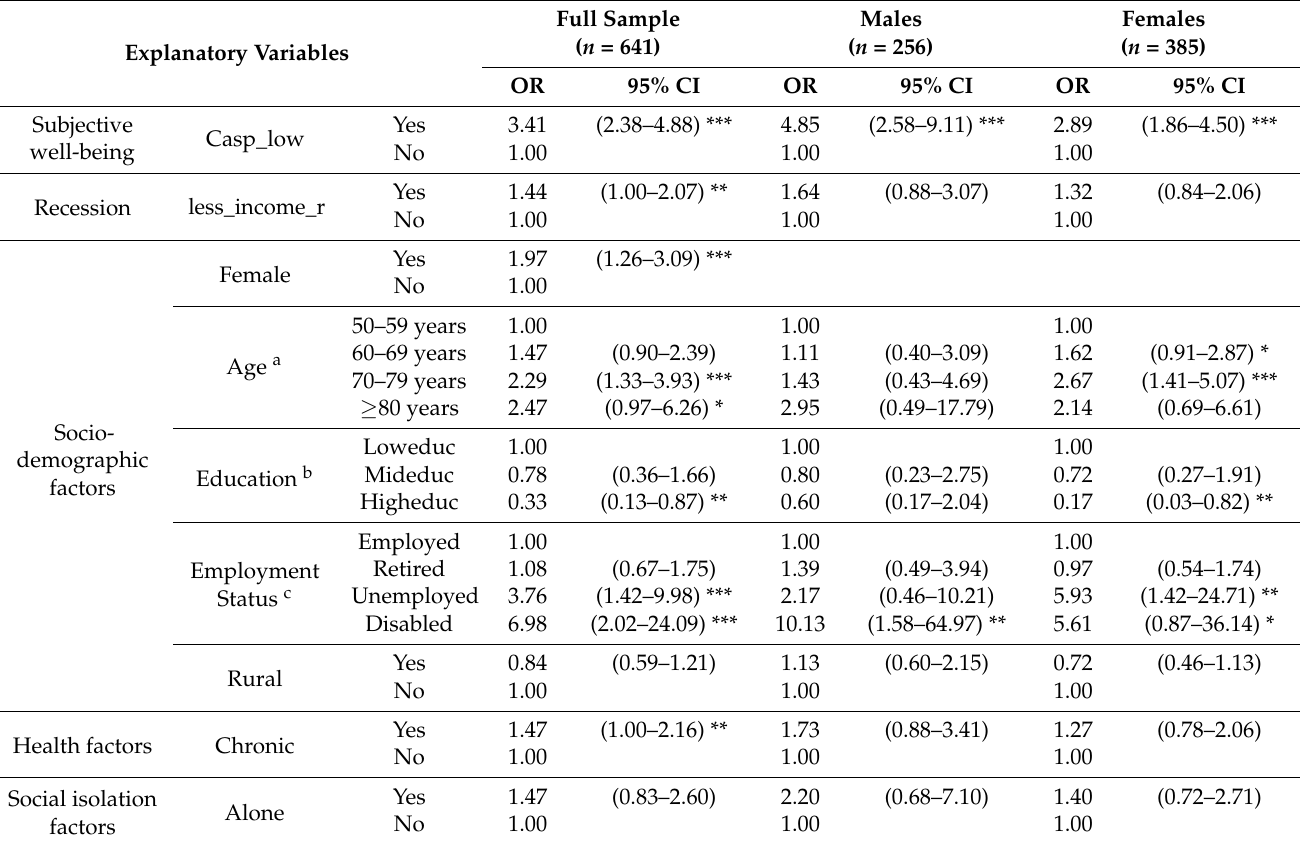
Table 3. Logistic regressions models (odds ratios and 95% confidence intervals).